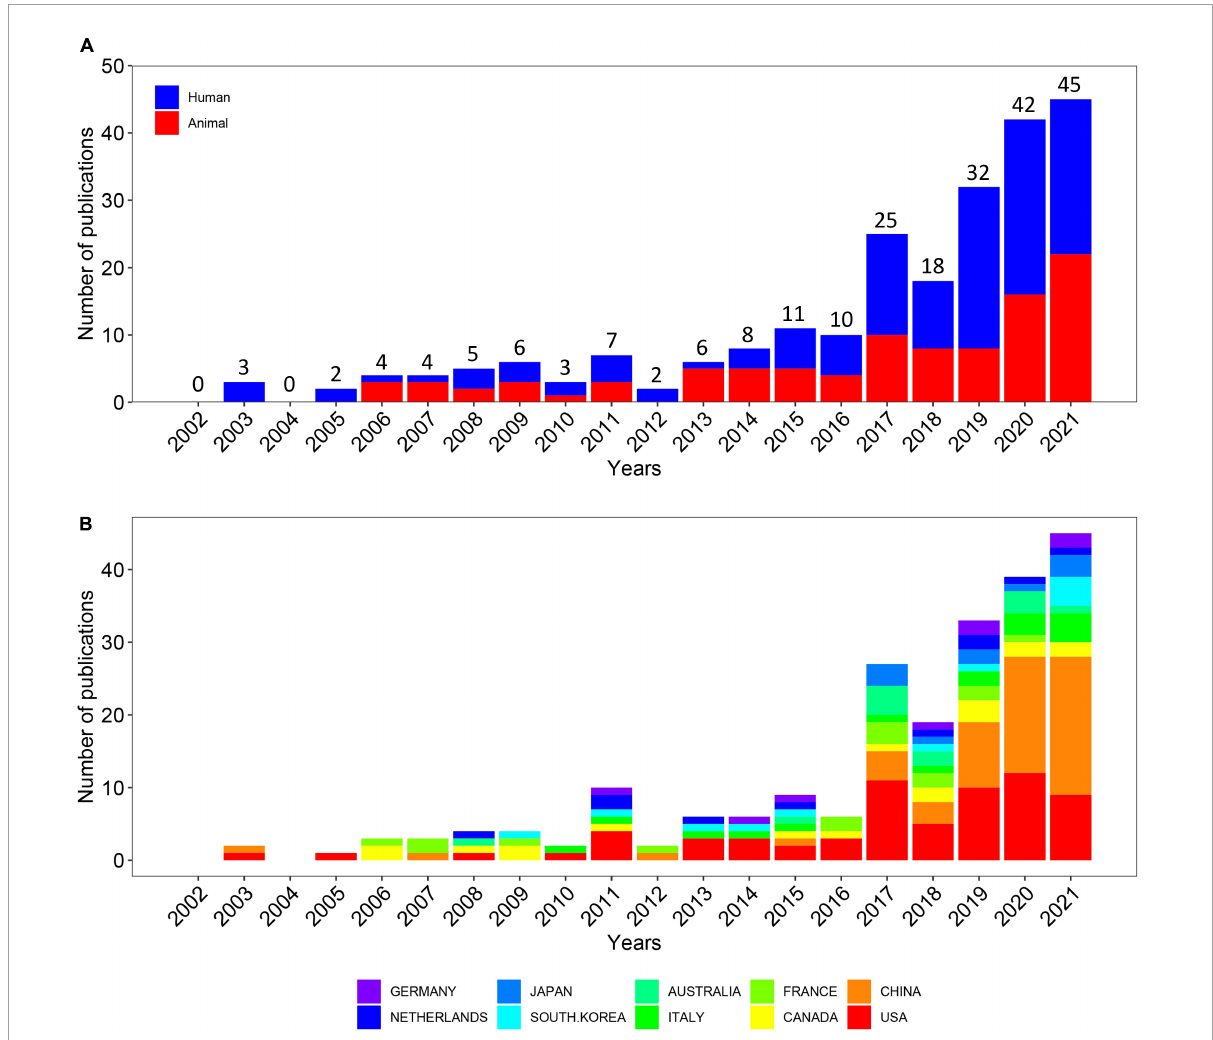
FIGURE2 Quantity and trends analysis of published papers. (A) Number of annual research publications and growth trends on the topic of the links between the gut microbiota and pain from 2002 to 2021, export of results from web of sciences. The red color represents animal experimental studies and the blue color represents clinical trials. (B) Number of annual research publications and growth trends on the topic of the links between the gut microbiota and pain from 2002 to 2022, export of results from the Online Analysis Platform of Literature Metrology.